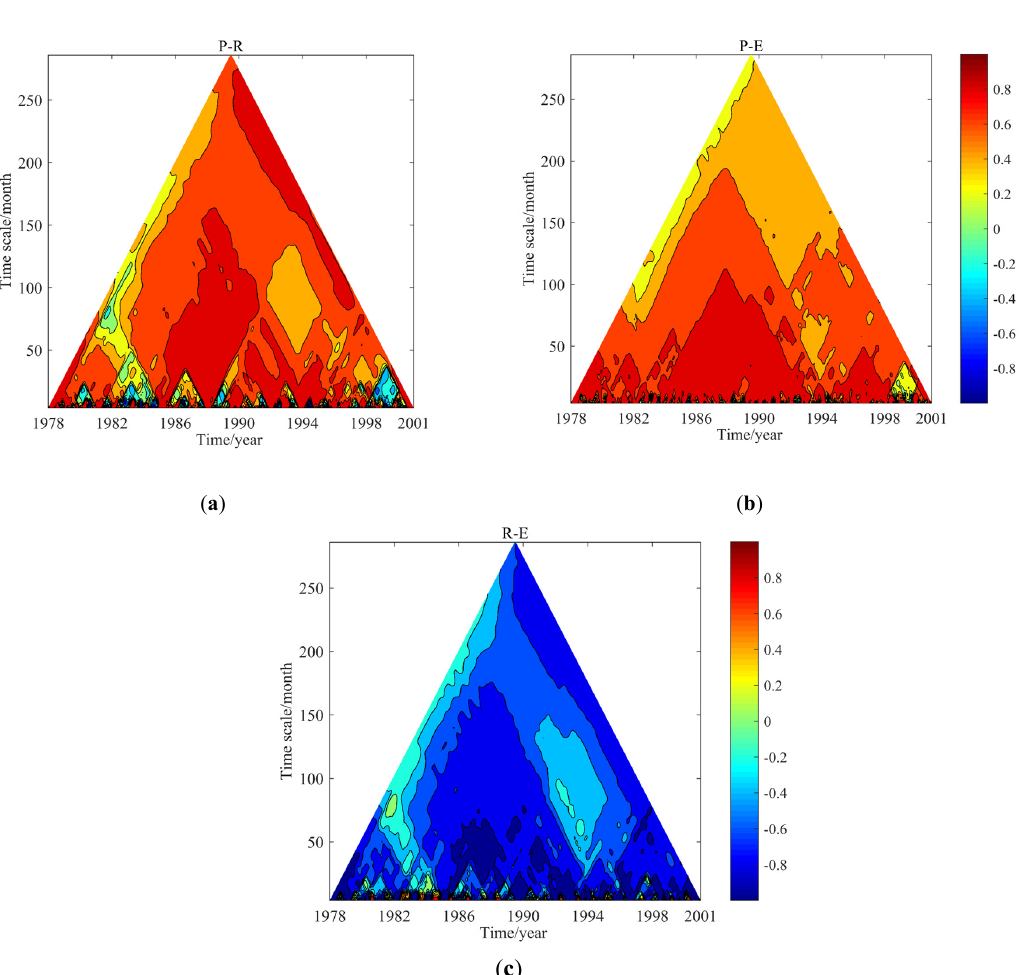
Figure 7. Temporal evolution of cross-correlation coefficients among P, R, and E obtained by temporal evolution of detrended partial-cross-correlation analysis (TDPCCA) i.e., P-R ( a ), P-E ( b ), and R-E ( c ).